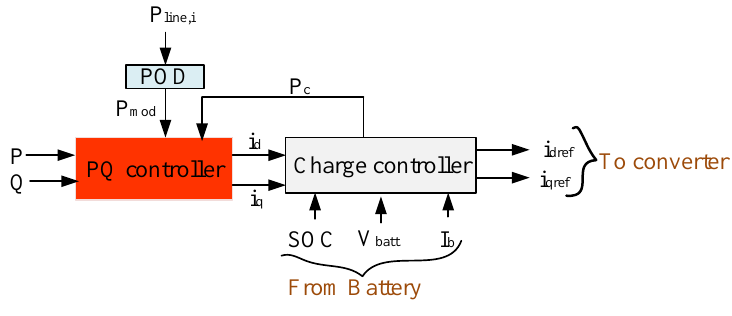
Figure 5. Schematic diagram of BESS